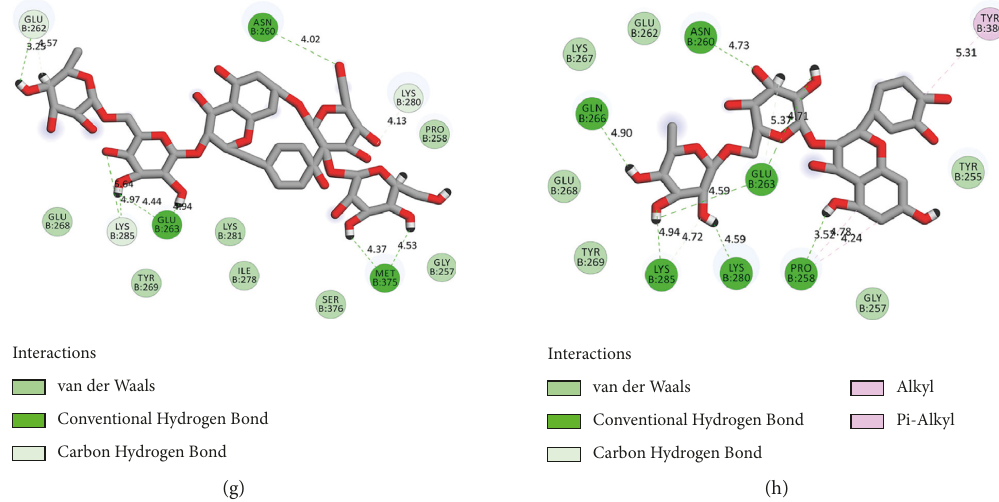
Figure 3: Interaction modes between residues within the SauPBP2a active site and top-ranked flavonoids. Before MD simulations using the AutoDock tool: (a) kaempferol 3-rutinoside-7-sophoroside, (b) rutin, (c) amentoflavone, and (d) quercetin. After 10 ns MD simulations: (e) kaempferol 3-rutinoside-7-sophoroside and (f) rutin. Using the Schr¨odinger Maestro docking software: (g) kaempferol 3-rutinoside-7- sophoroside and (h) rutin. SauPBP2a, Staphylococcus aureus penicillin-binding protein